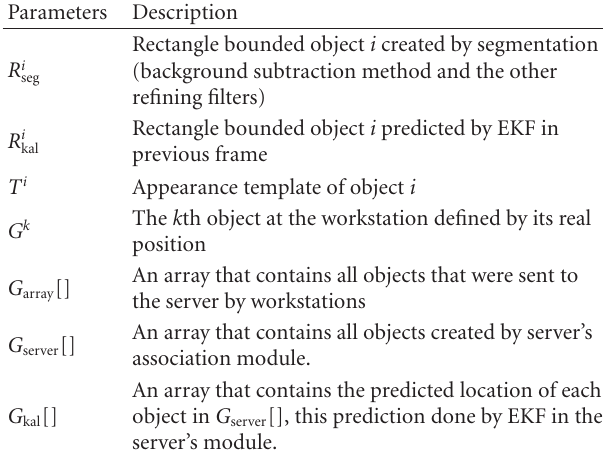
Table 2: Parameters used in the tracking